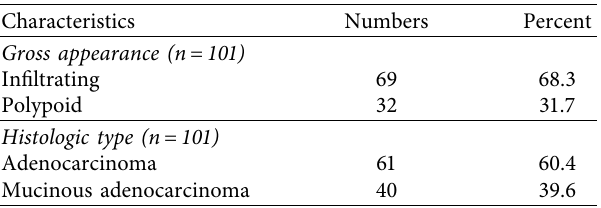
Table 2: Gross appearance and histopathological characteristics of colorectal carcinomas.